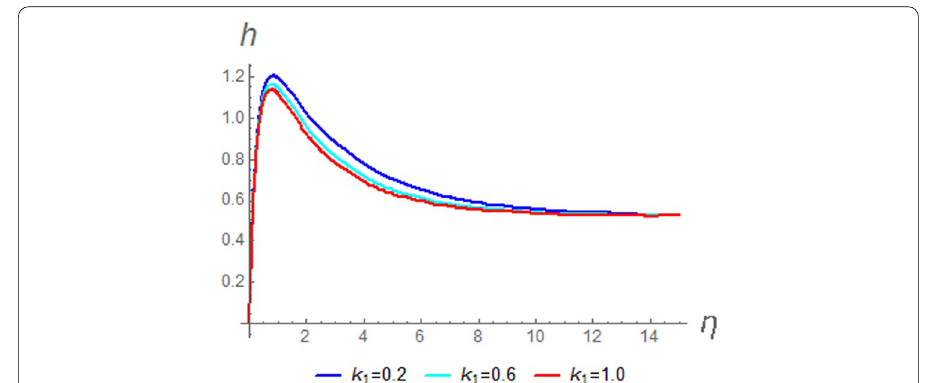
Fig. 8 Effect of k 1 on the velocity profile